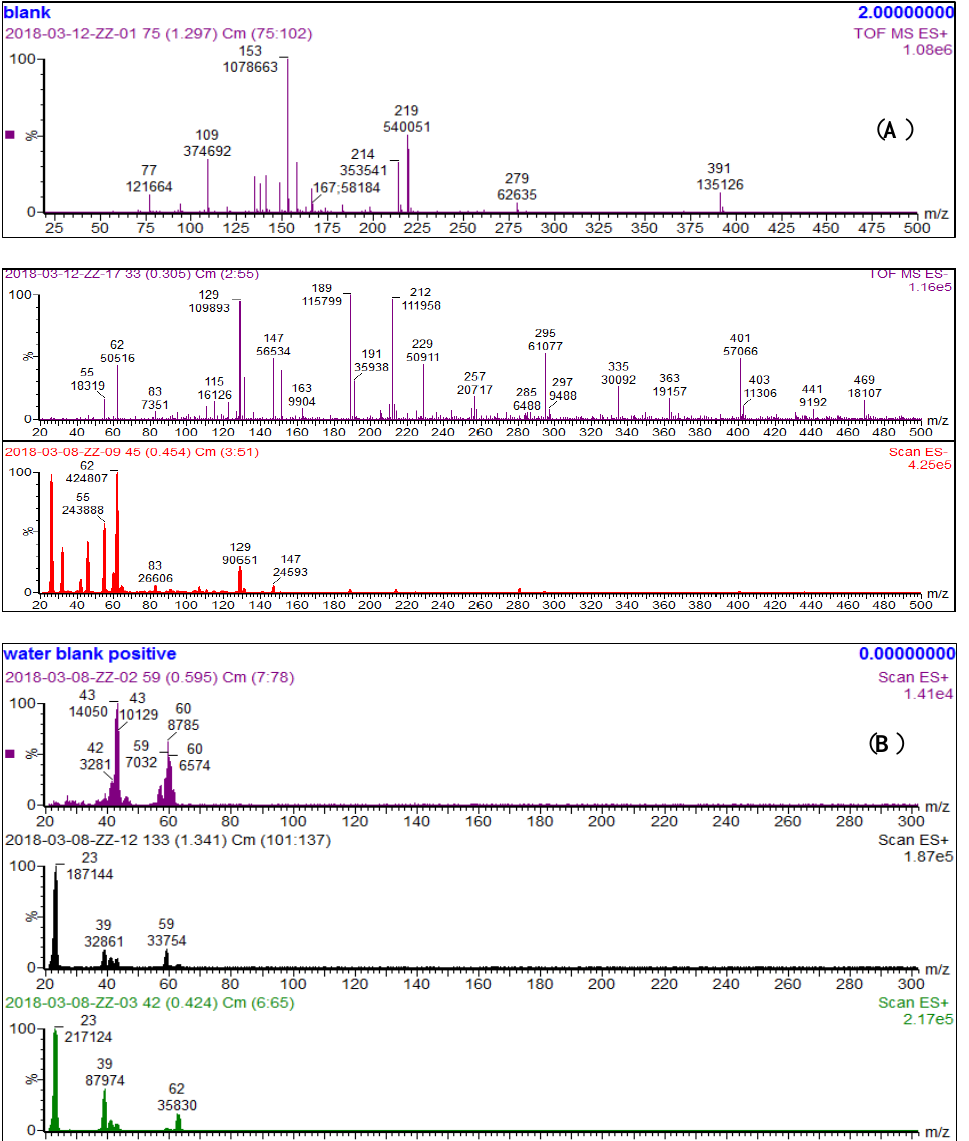
Figure 6. Electrospray ionization mass spectrometry (ESI-MS) analysis of NTO-wastewater and plant exudates at ( A ) negative mode and ( B ) positive mode. Both figures contain a blank (top), NTO-wastewater (middle), and plant exudates (bottom). NTO peak was recorded at an m/z ratio of 129 Da in both NTO-wastewater and plant exudates under negative mode.